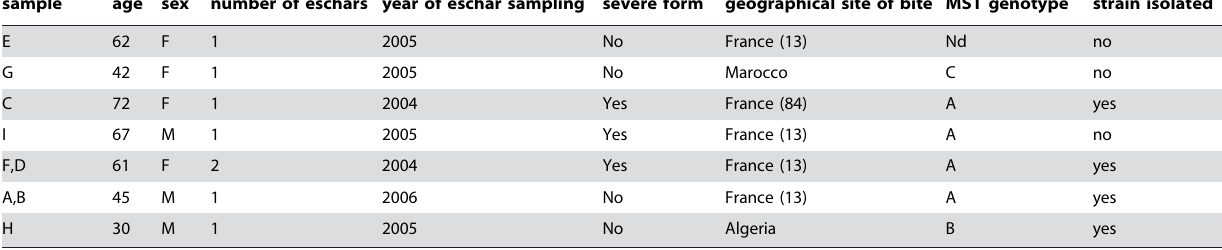
Table 1. Clinical characteristics of patients included in this study.